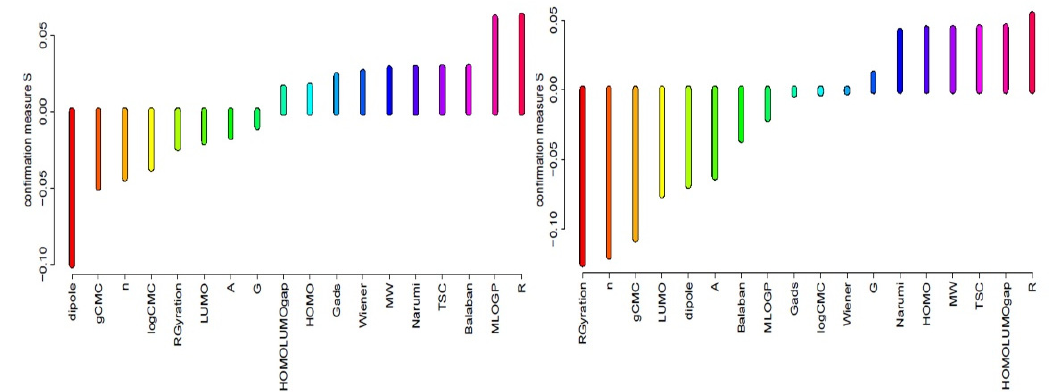
Figure 2. Predictive attribute confirmation calculated for MIC decision classes PAE “weak” (left) and “good” (right).